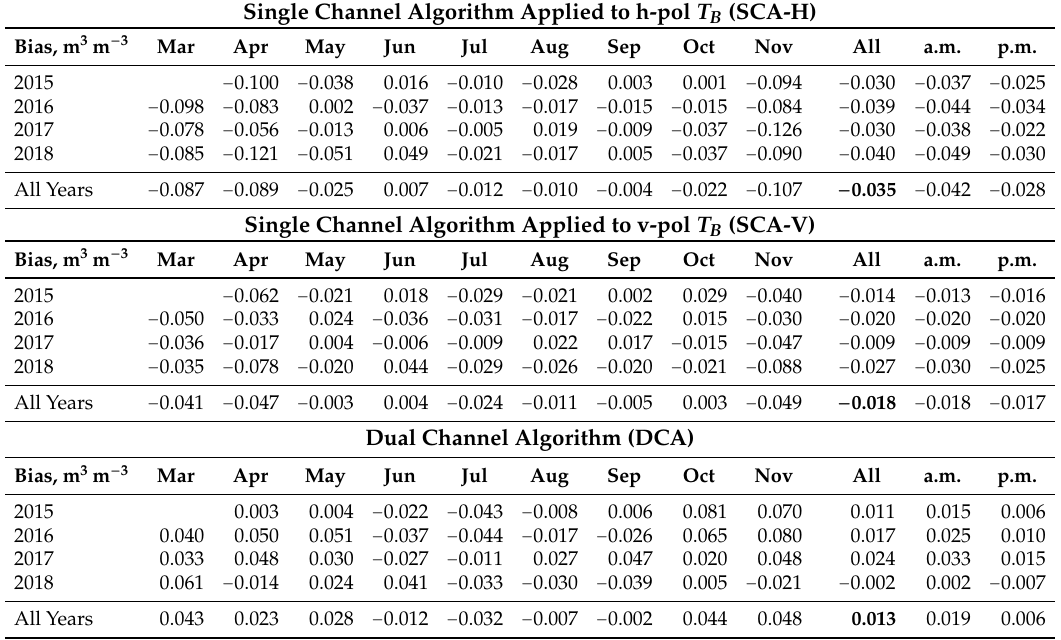
Table 1. Bias between SMAP Level 2 Soil Moisture (L2SM) and South Fork weighted average soil moisture